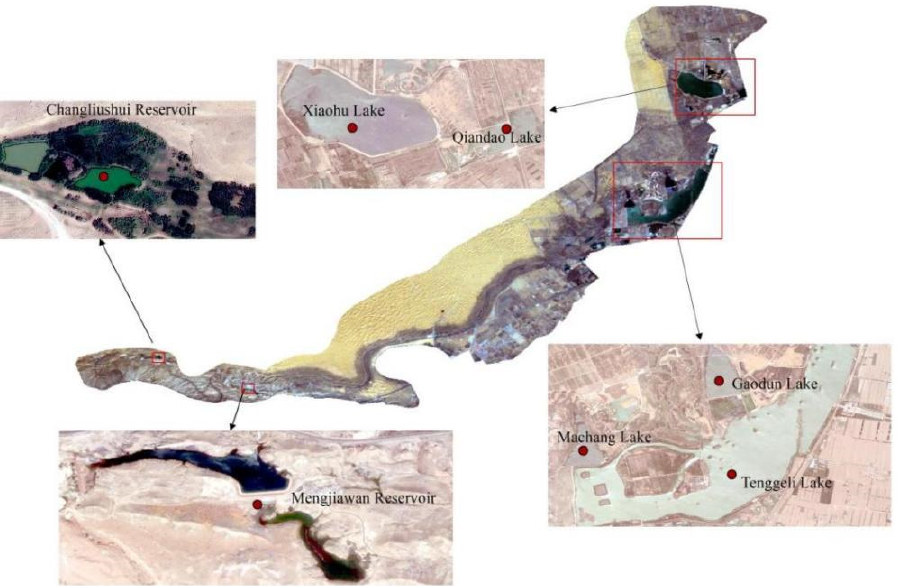
Figure 4. Google Earth satellite imagery of water bodies. To present the best display image, some areas without water bodies are not shown. Each individual area shown is a Google Earth satellite imagery. The complete main image in the middle is the March 2019 Landsat-7 data.